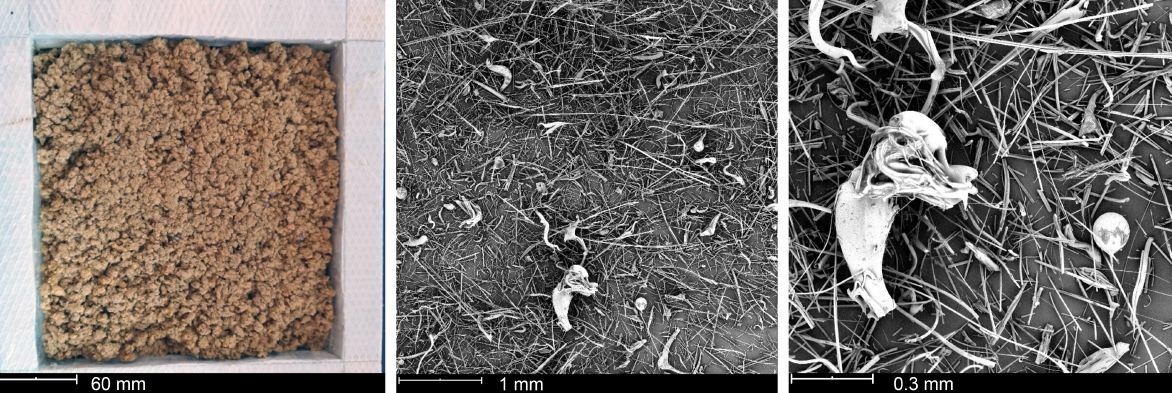
Figure 5. Representative optical and SEM images of chopped mineral wool waste (set